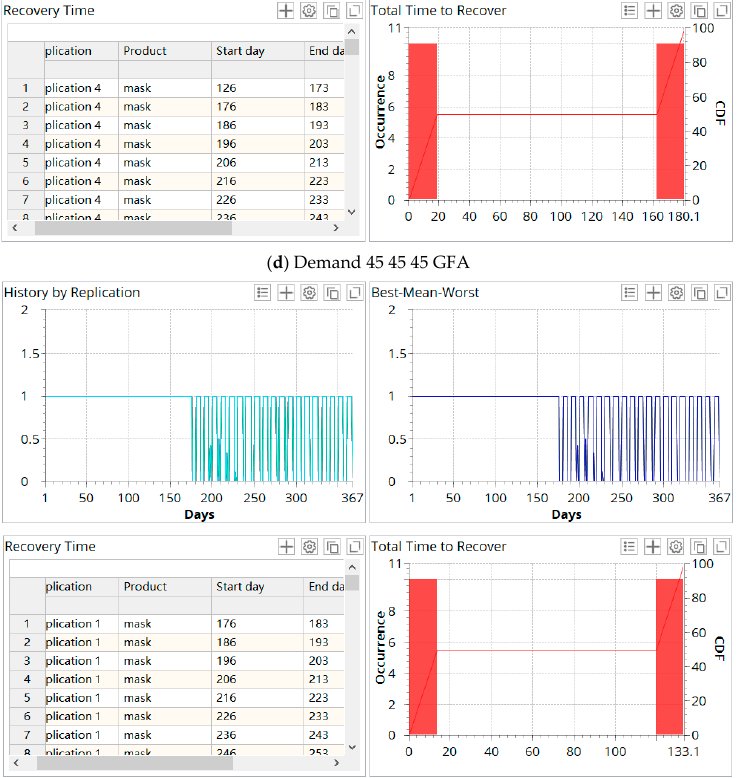
Figure 8. Risk analysis experiment.